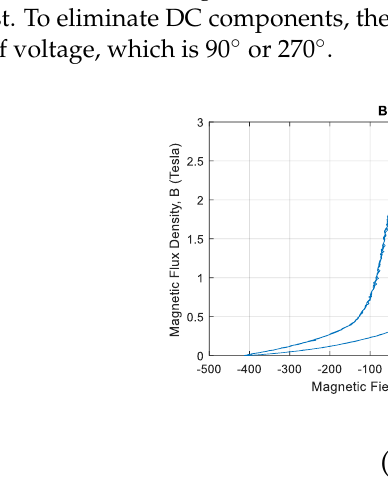
Figure 7. Effect on the B – H curve of the initial integration position of the voltage phase at 0°. ( a ) The voltage integration waveform shifted upward. ( b ) B – H curve shifted upward.